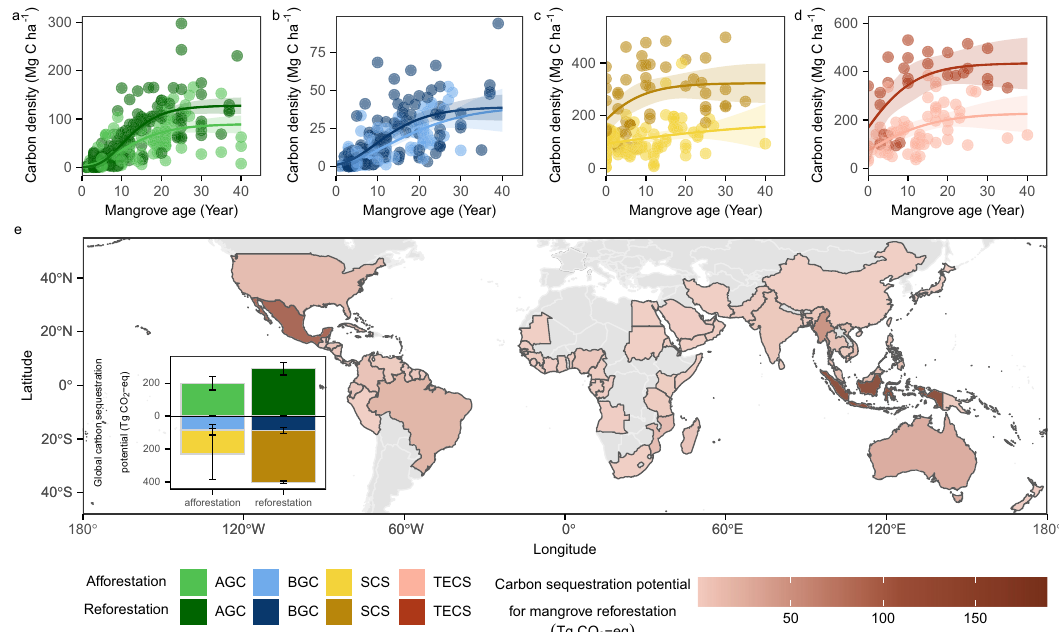
Fig. 4 | Carbon sequestration potential if mangrove afforestation and refor- estationprojectsareimplementedgloballyovera40-yearperiod.a – d Changes in carbon density among pools over time during mangrove reforestation and afforestation. a Abovegroundbiomasscarbon(AGC)pool( n =167forreforestation, n =138 for afforestation); b Belowground biomass carbon (BGC) pool ( n =129 for reforestation, n =124 for afforestation); c Sediment carbon (SCS) pool ( n =50 for reforestation, n =108forafforestation);and d Totalecosystemcarbon(TECS)pool ( n =28 for reforestation, n =63 for afforestation). Fitted lines and ribbons are cal- culated as the predicted values and the 95% con fi dence intervals for the 2.5th and